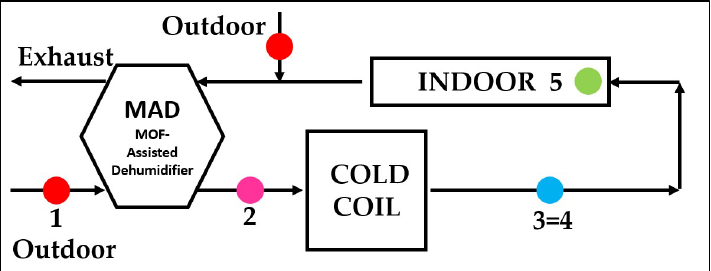
Figure 4. Schematic representation of a HVAC system with MOF-assisted dehumidification. A generic complete process is represented in Figure 5.